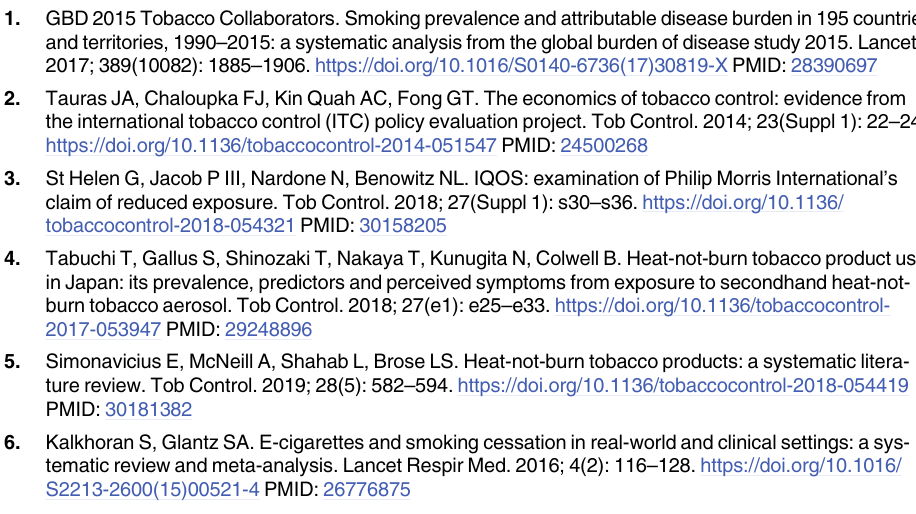
S3 Table. Variance inflation factors to evaluate multicollinearity of each variable for main and sensitivity analyses. S1 Fig. A directed acyclic graph of this study.